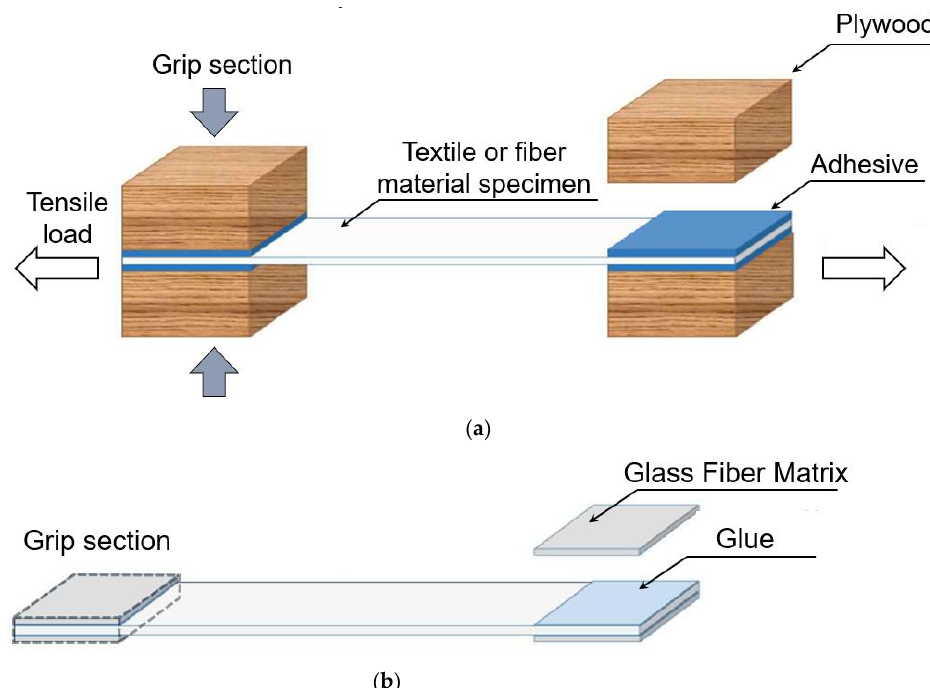
Figure 4. Schematic illustration of the preparations of the testing samples: ( a ) conventional method and ( b ) proposed method.